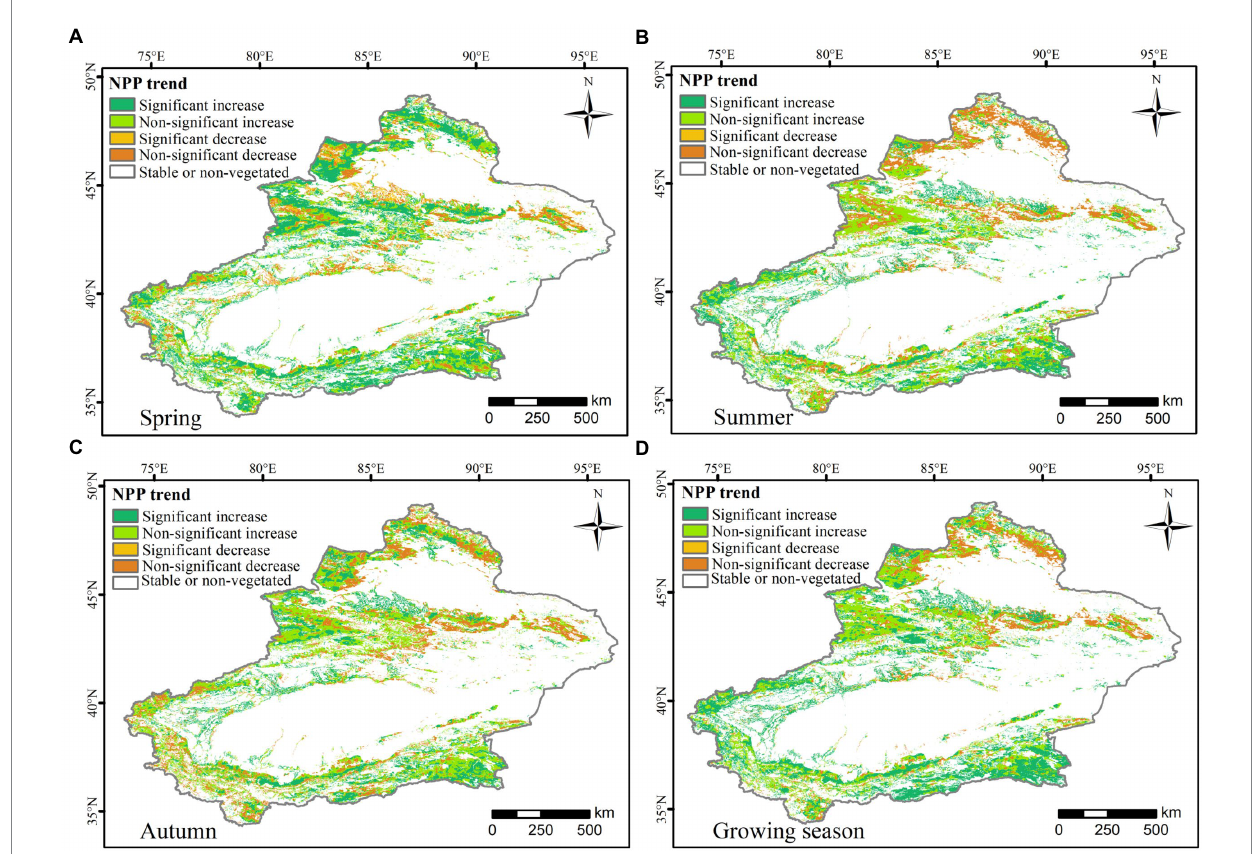
FIGURE 4 Spatial variation pattern of grassland NPP in (A) spring, (B) summer, (C) autumn, and (D) the growing season in Xinjiang from 1982 to